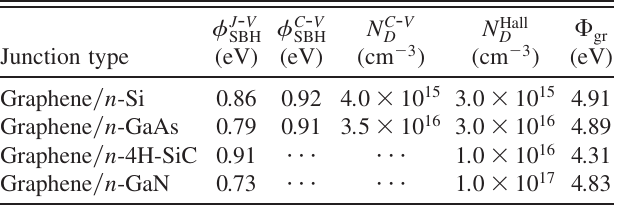
TABLE I. Extracted SBHs, doping densities, and correspond- ing graphene-work-function values on various graphene/ semiconductor